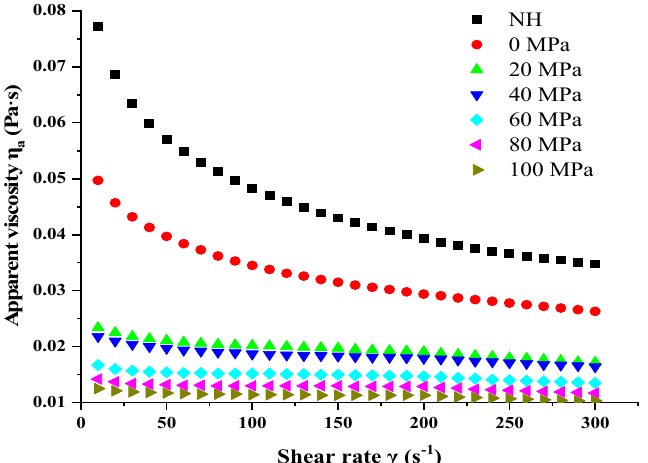
Figure 8. Apparent viscosity ( η a × γ ) of lily pulp treated by high-pressure homogenization (0–100 MPa) and NH (non-homogenized) sample.